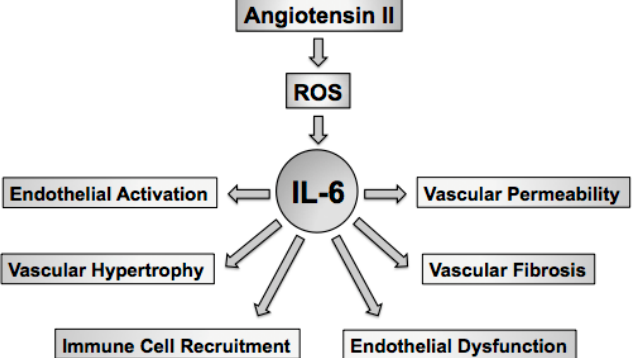
Figure 1. Vascular expression of IL-6, such as that produced by angiotensin II, is associated with alterations in vascular function and structure. Increases in reactive oxygen species, such as superoxide, serve to increase IL-6 expression in vascular cells. Increases in vascular or immune cell-derived IL-6 serve as a key mediator of several vascular phenotypes that are produced in response to angiotensin II. IL-6, interleukin-6; ROS, reactive oxygen